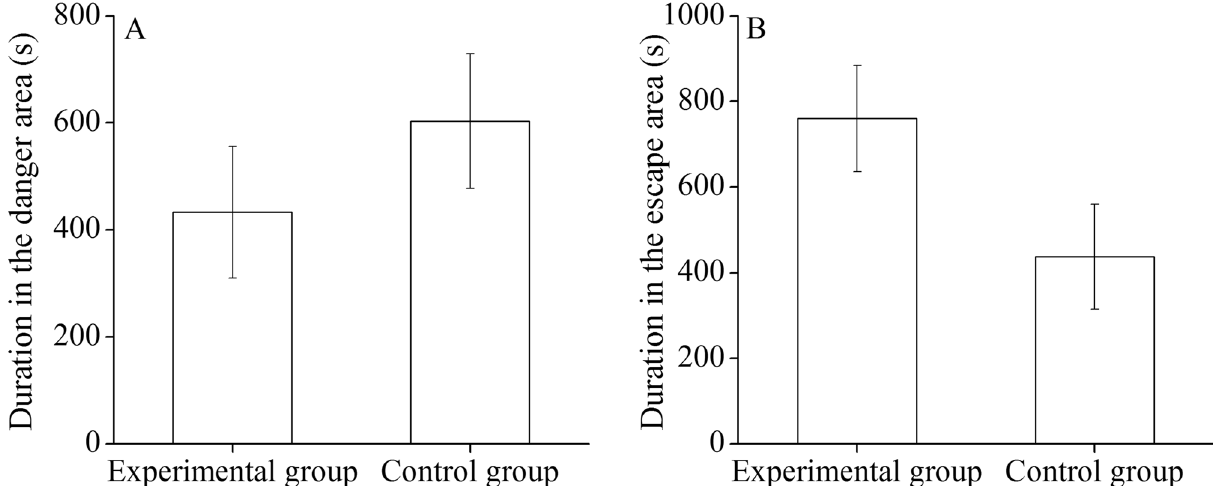
Figure 1. Experiment 1: duration in the danger area ( A ) and in the escape area ( B ) in the experimental and control